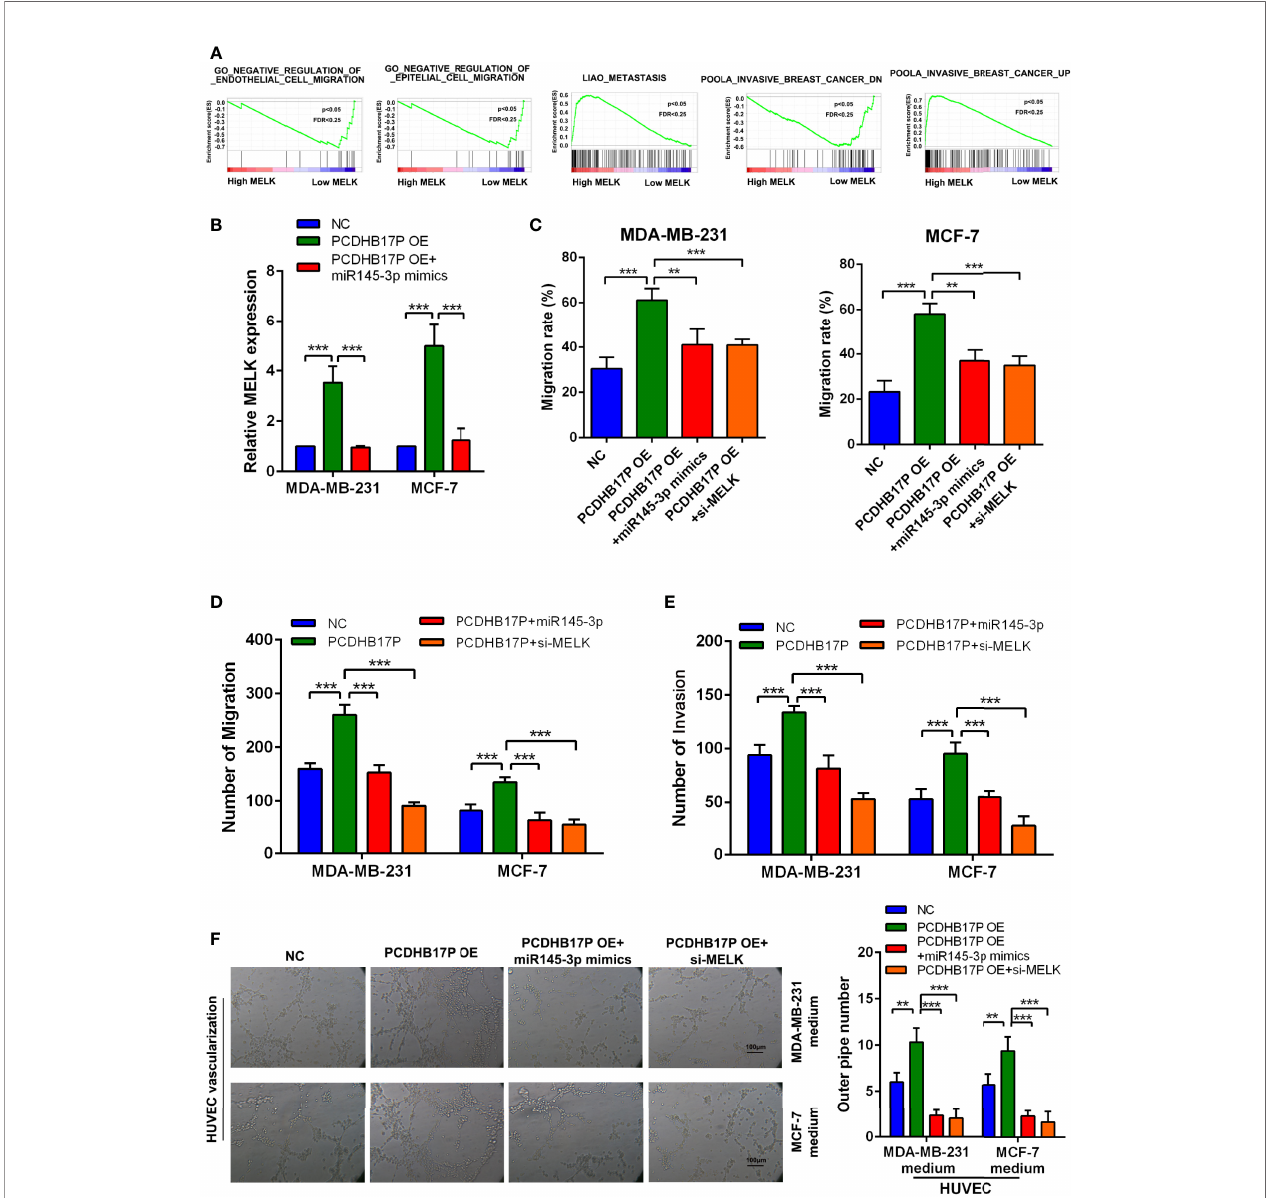
FIGURE 7 | PCDHB17P promotes MELK-mediated metastasis and angiogenesis through miR-145-3p sponging in vitro (A) GSEA revealed that MELK expression was related to metastasis and angiogenesis in breast cancer. (B) RT-qPCR results of the expression of MELK in MDA-MB-231 and MCF-7 cells in response to PCDHB17P overexpression, or PCDHB17P overexpression plus miR-145-3p mimics. (C – E) Wound healing and transwell assays were used to assess metastasis of breast cancer cells transfected with PCDHB17P or PCDHB17P simultaneously with miR-145-3p mimics or si-MELK. (F) Tube formation of HUVEC cell was detected and results were expressed as number of branches. ** P < 0.01, *** P <